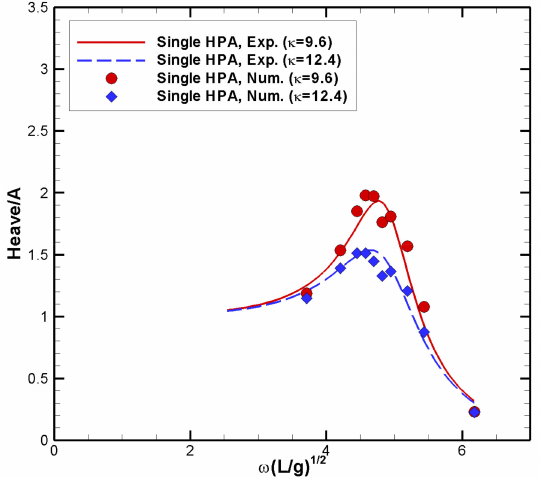
Figure 13. Heave RAO of single HPA with different PTO damping